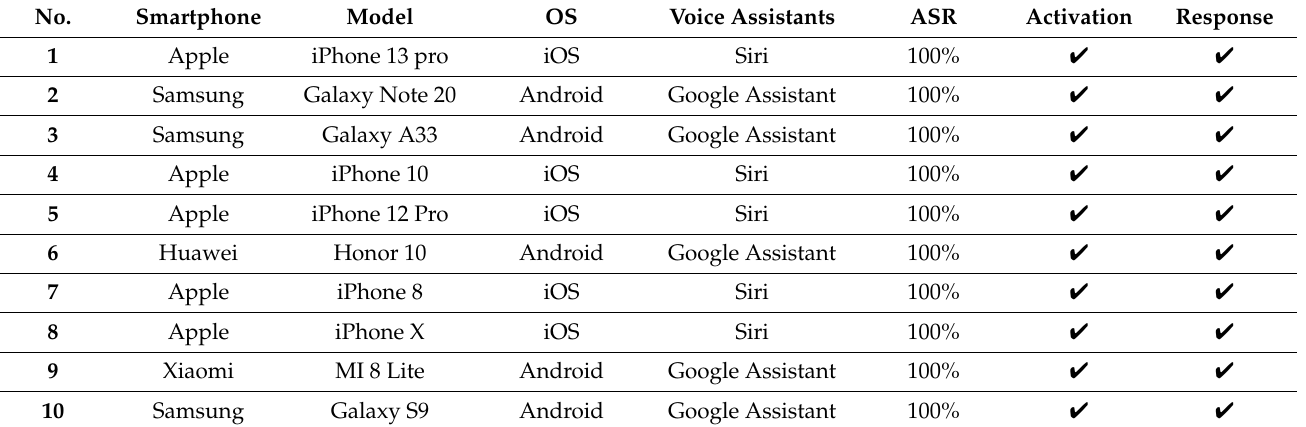
Table 6. Devices for the experiment: operating systems and device model. CableAttack components, including activation of the voice assistant (Activation), response from the device—listening to the request